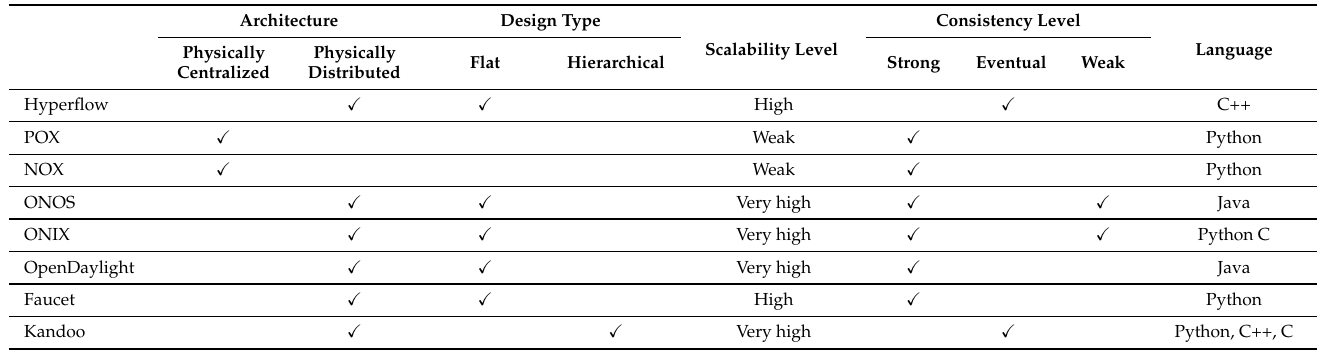
Table 1. Characteristics of the SDN controller